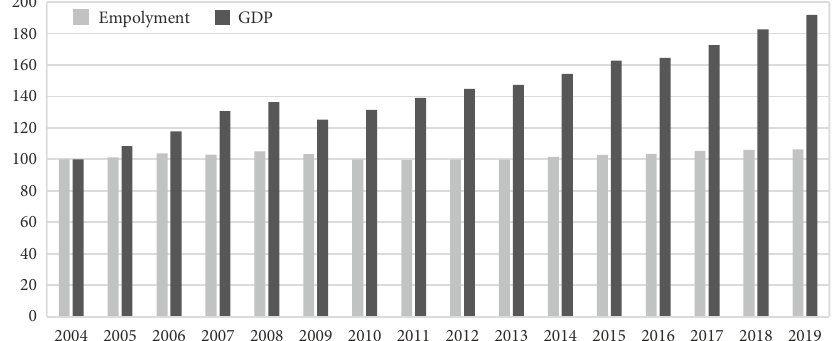
Figure 2. Dynamics of changes in average GDP values (constant prices, EUR) and the average number of the employed in the analysed CEE countries (2004 = 100)